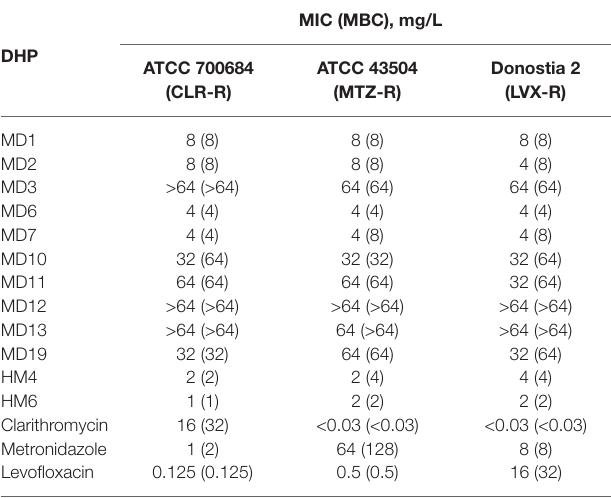
TABLE 1 | Minimal inhibitory and bactericidal concentrations of 12 DHP-based HHQ derivatives against different antibiotic-resistant strains of H.